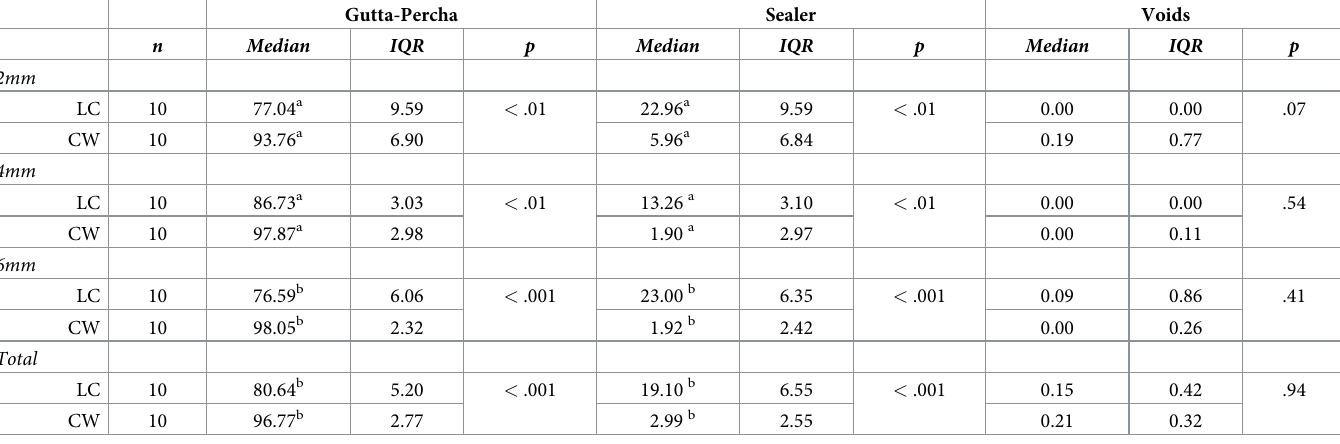
Table 7. Descriptive statistics and Kruskal-Wallis test results on the percentages of gutta-percha, sealer and voids according to level of sections independent from shaping system in C2-type.